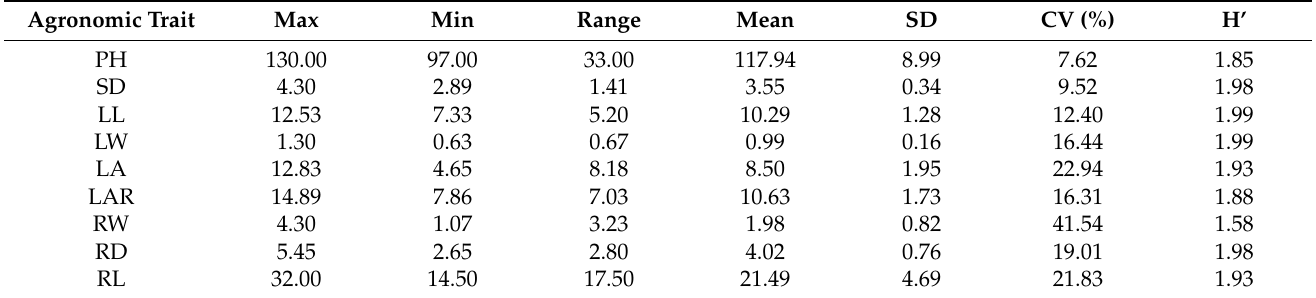
Table 5. Diversity analysis of agronomic traits of different Radix bupleuri varieties. Agronomic